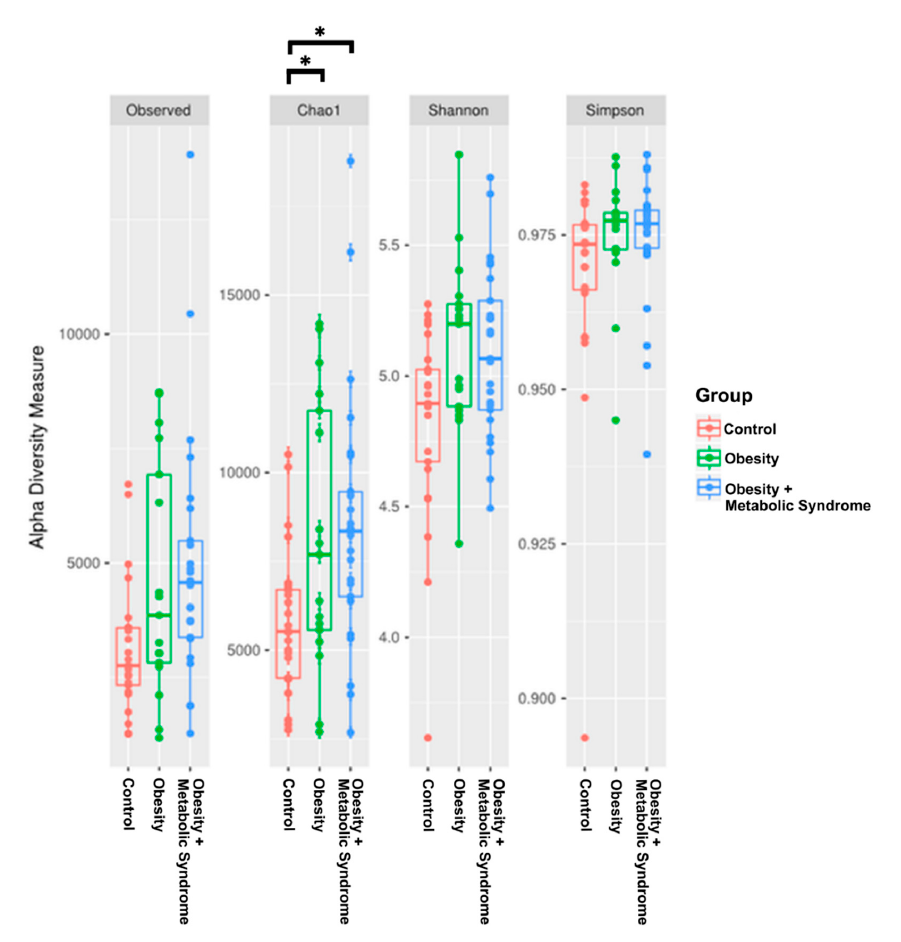
Figure 2. Bacterial alpha diversity. The box-plot figures show the alpha diversity of the bacterial communities in the three study groups Control, OB, and OMS by means of observed Operational Taxonomic Units (OTUs), and Chao1, Shannon, and Simpson indexes. Plotted in the graphic are the interquartile ranges (IQRs) and boxes, medians (lines in the boxes), and lowest and highest values for the first and third quartiles. Each phenotypic category is identified by colors, as indicated on the right side of the figure. Every sample is represented by a colored dot. Solid lines and asterisks indicate a significant difference between control and obesity (lower), ( p < 0.002), and control and obesity + metabolic syndrome (upper) ( p < 0.003). P -values were calculated to compares alpha diversities based on a two-sample t -test using a non-parametric methods and the default number of Monte Carlo permutations in order to find different significances among groups (see Table S9).